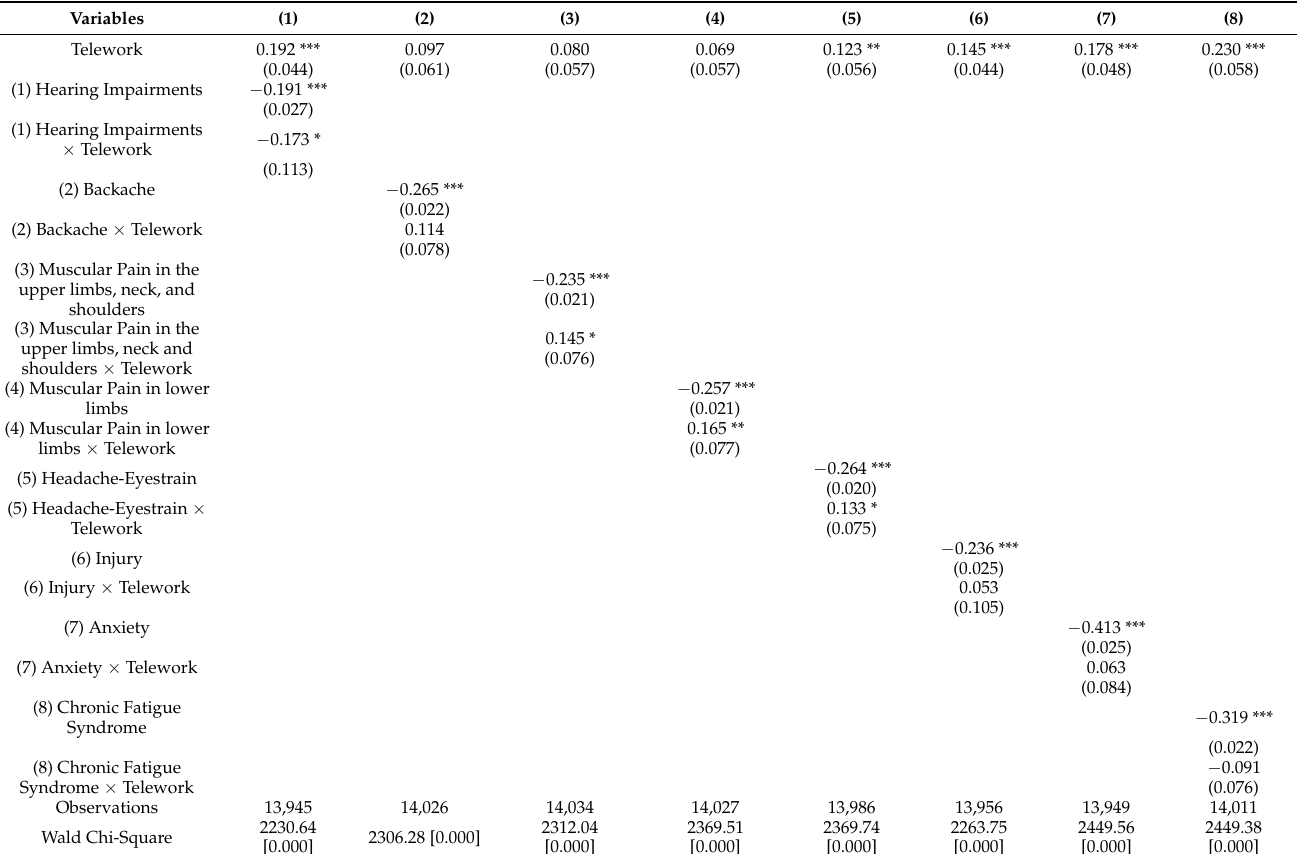
Table 4. Telework and Job Satisfaction for Workers with and without Health